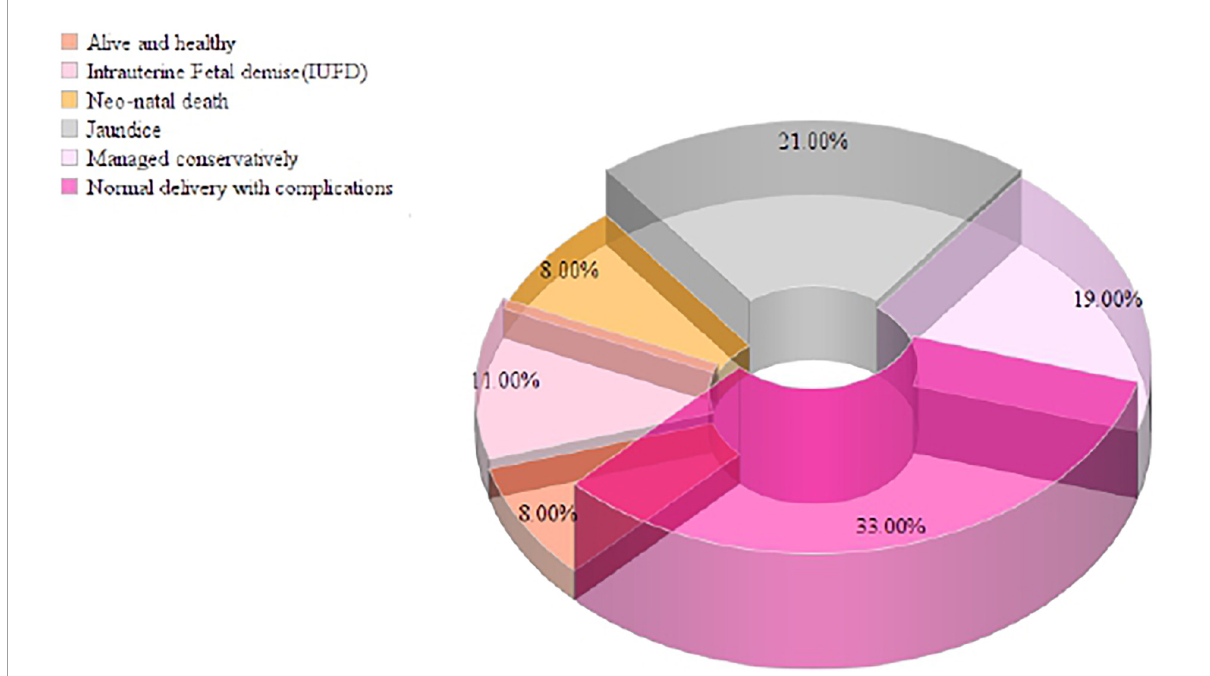
FIGURE5 Fetomaternal outcome of HEV-seropositive pregnant women in the study